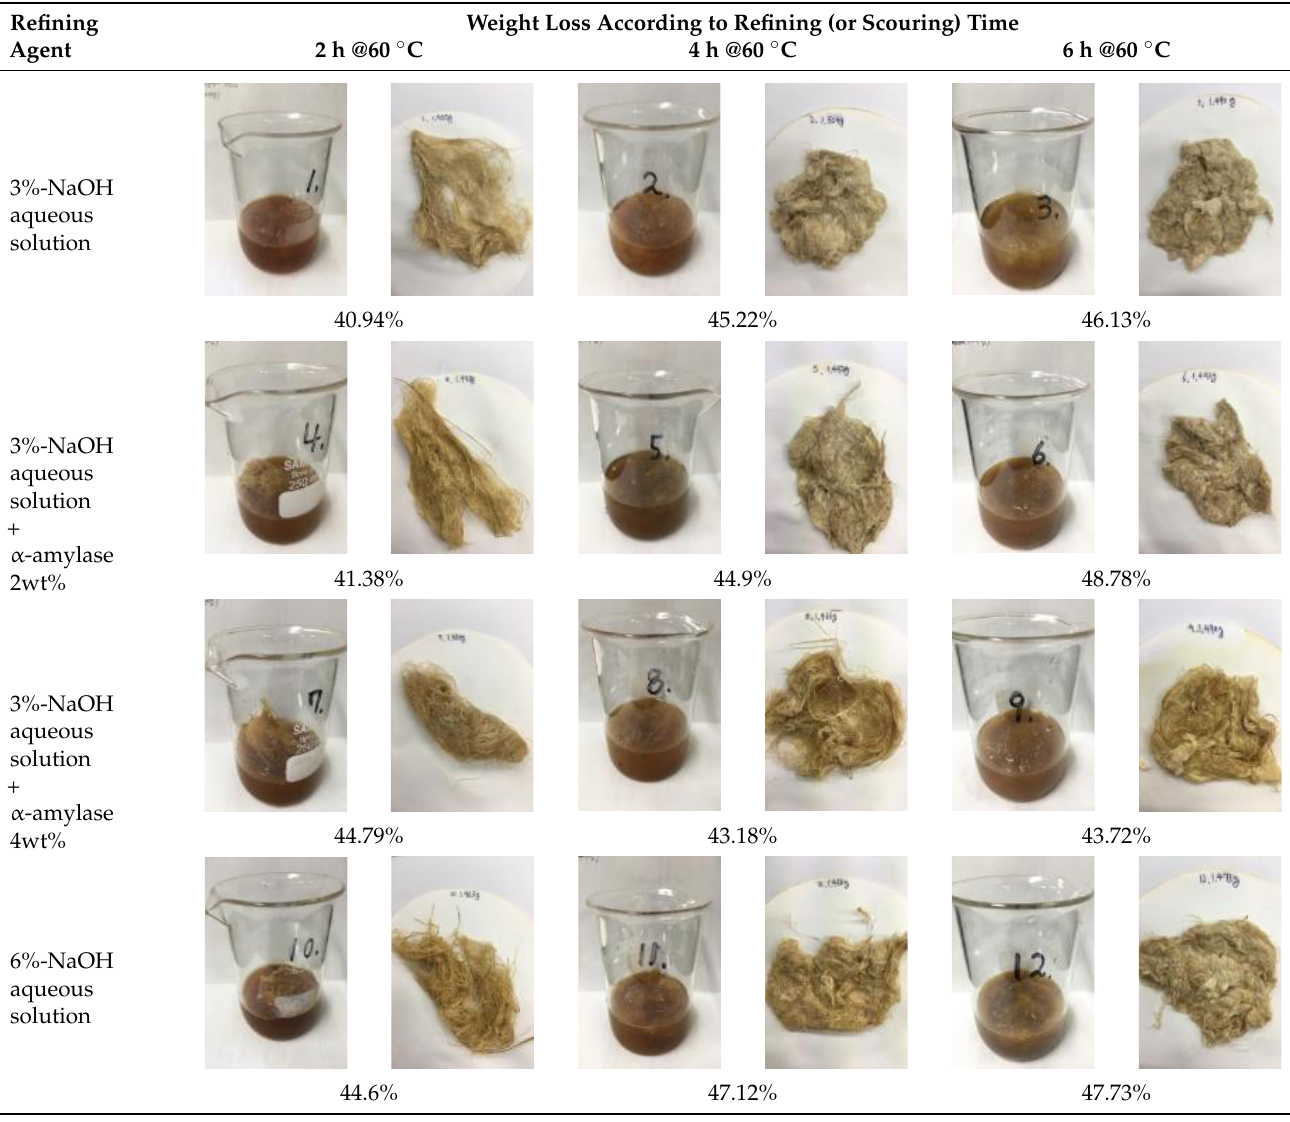
Table 1. Weight loss according to refining (or scouring) time.